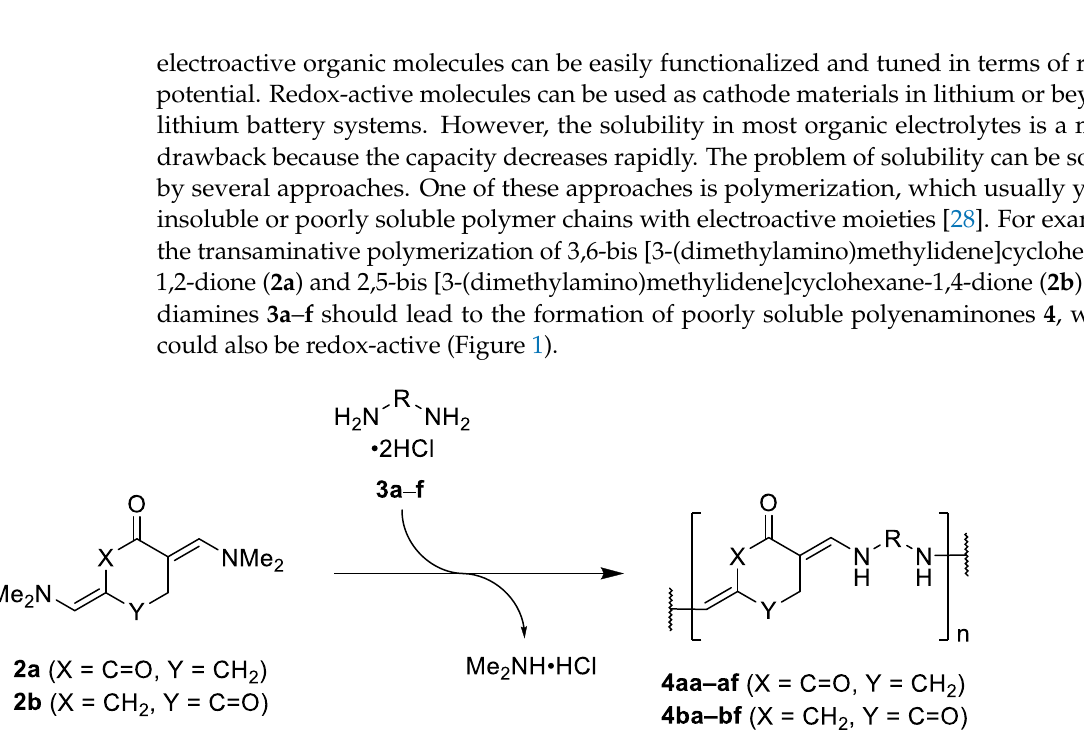
Figure 1. Preparation of polyenaminones 4 by acid-catalysed polymerisation of diamines 3a – f with α,α -bis[(dimethylamino)methylidene]cyclohexanediones 2a , b .